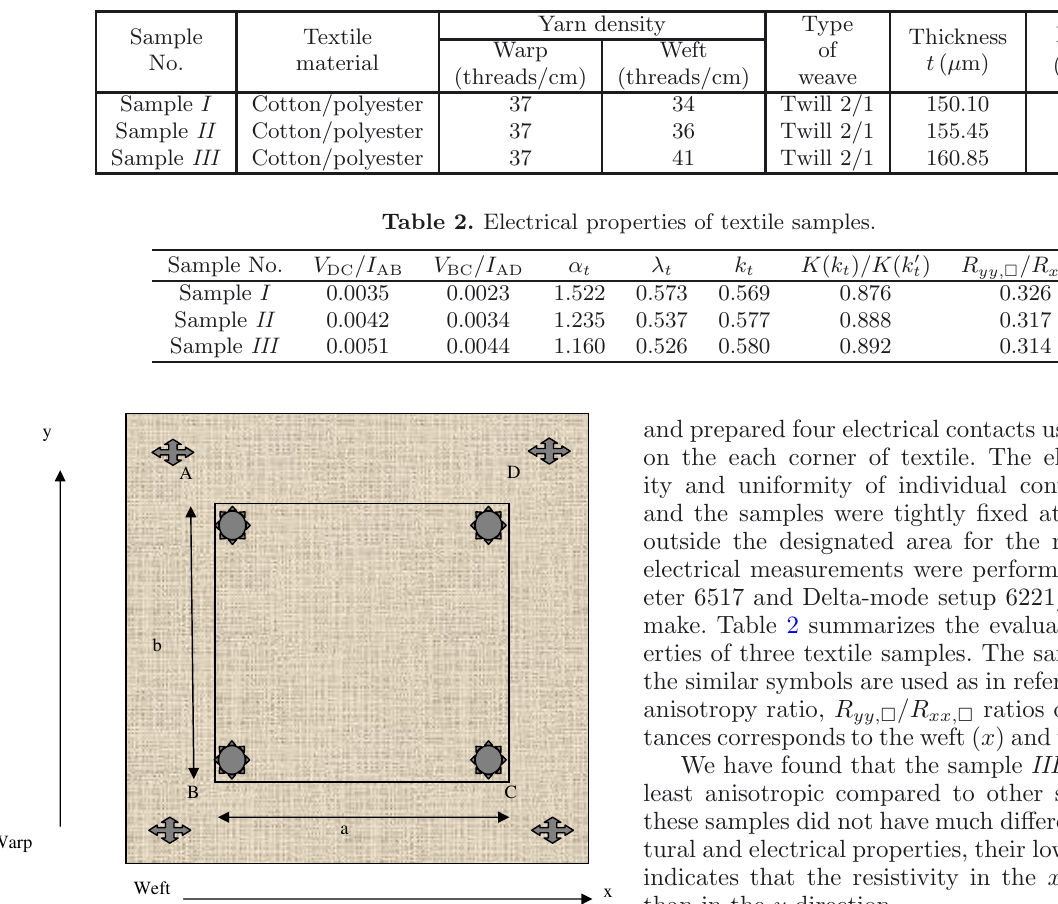
Table 1. Structure properties of textile samples.